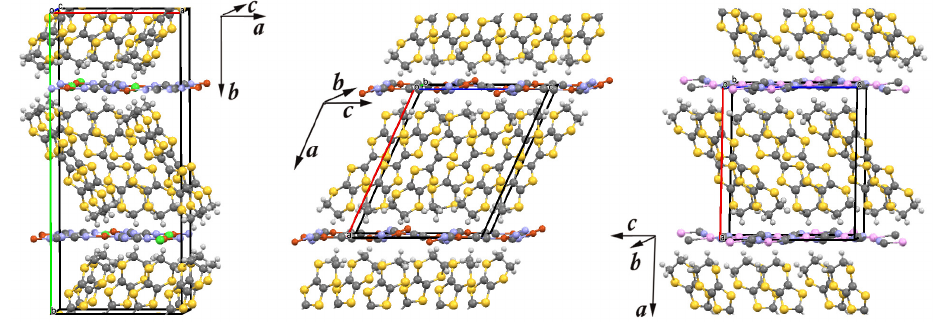
Figure 1. The crystal structure of the three layered organic charge-transfer salts. The lines mark the unit cell. Carbon, sulfur and hydrogen atoms of the BEDT-TTF molecule are colored in dark gray, yellow and light gray, respectively. In the anion network, chlorine, cooper, silver, carbon and nitrogen are colored in green, red, pink, dark grey and violet, respectively. ( Left ) Unit cell of κ -Cl. The space group is P nma . In each of two organic layers, related by mirror symmetry, all four BEDT-TTF molecules are equivalent. ( Middle , Right ) Extended unit cell of κ -CuCN and κ -AgCN, respectively. The space group is commonly solved in P 2 1 / c in which all four BEDT-TTF molecules are equivalent.